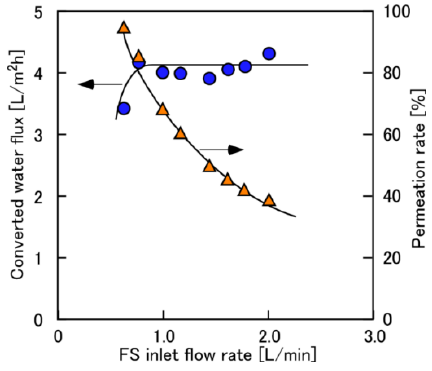
Figure 3. Converted water flux and permeation rate as a function of Q FS,in . PRO conditions: Δ P , 11 bar;